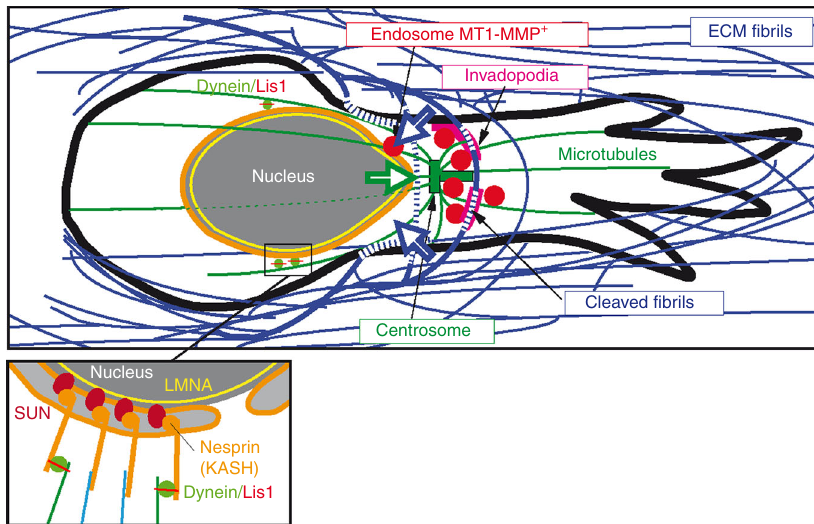
Fig. 6 Model of LINC complex-, Lis1-dependent nucleus-centrosome linkage control of MT1-MMP matrix digest-on-demand response. Con fi ned migration of tumor cells through dense 3D collagen network results in nucleus con fi nement by constricting collagen fi brils. Nucleus-microtubule cytoskeleton linkage through LINC complex and dynein heavy load factor Lis1 and cortical anchoring of microtubules is required for centrosome and MT1-MMP endosome positioning and for targeted delivery of MT1-MMP to invadopodia. Nucleus movement is facilitated by localized invadopodia-based pericellular proteolysis of con fi ning fi brils ahead of the nucleus. Open arrows represent nuclear pulling force and counteracting forces from the matrix. Inset, scheme of nucleus- cytoskeletal linkage through LINC complex components nesprin and SUN in association with lamins. Lis1, probably in complex with dynein associates to the NE depending on Nesprin-2 and is involved in nucleus-microtubule